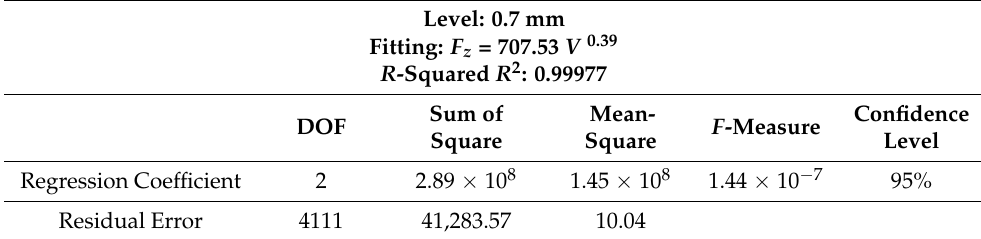
Table 3. Significance analysis.